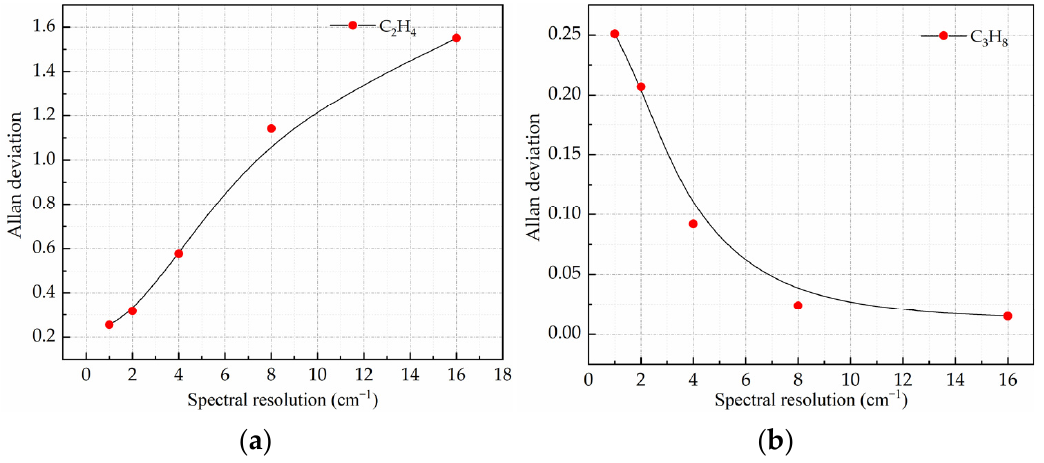
Figure 9. ( a ) The Allan deviation of C 2 H 4 concentration with different spectral resolutions; ( b ) the Allan deviation of C 3 H 8 concentration with different spectral resolutions.